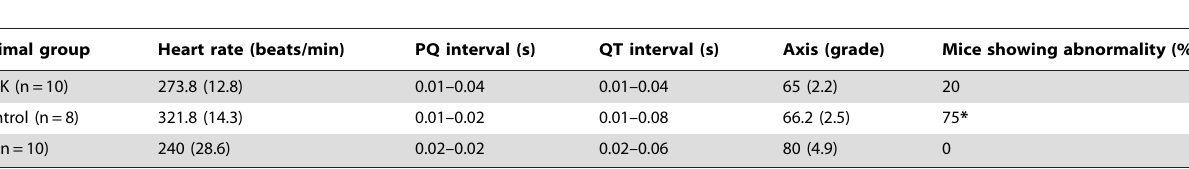
Table 1. Electrocardiographic results in 3-HK treated, Control (infected and untreated) and Normal non-infected (NI) mice at 60 days